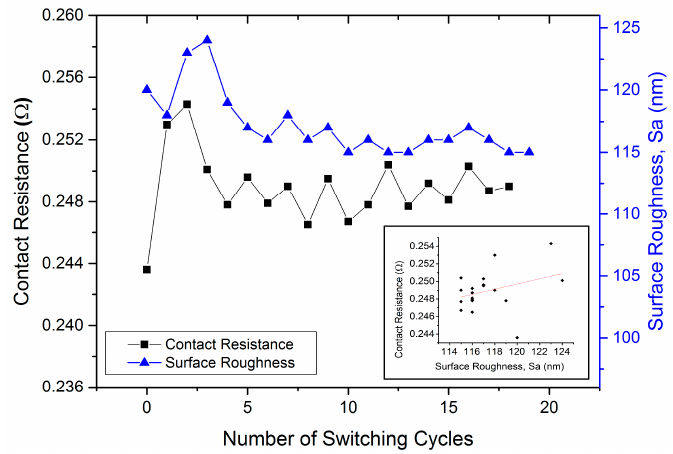
Figure 10. The evolution of contact resistance and surface roughness over 20 hot switched 4 V Direct Current (DC) 20 mA switching cycles.